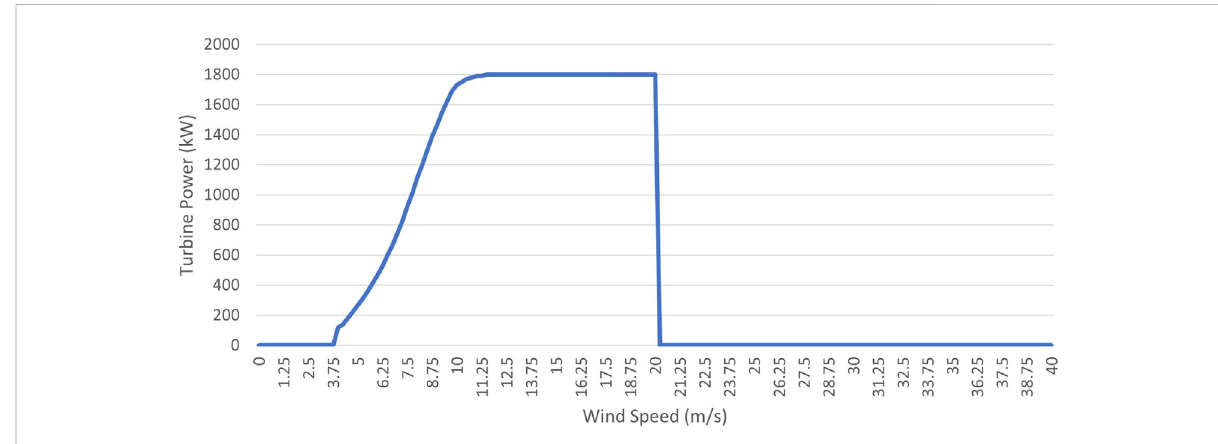
FIGURE 3 V100-1.8 turbine power curve. Source: Developed from SAM simulation data (NREL,